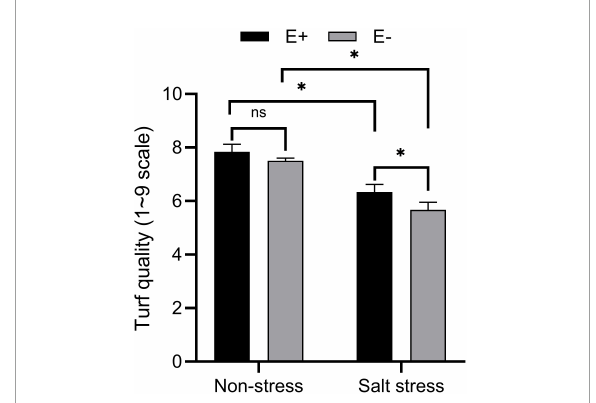
FIGURE1 Effects of bermudagrass turf quality of inoculated and uninoculated plants under salt stress. Bars denote means ± SE of four treatment. “Non-stress” represents bermudagrass grown without NaCl condition; “Salt stress” represents bermudagrass under 250 mM salt conditions. “E + ” represents the infection of Enterobacter ludwigii , “E − ” represents the absence of E. ludwigii. “ ∗ ” indicate significant differences at P < 0.05 and “ns” represents no significant